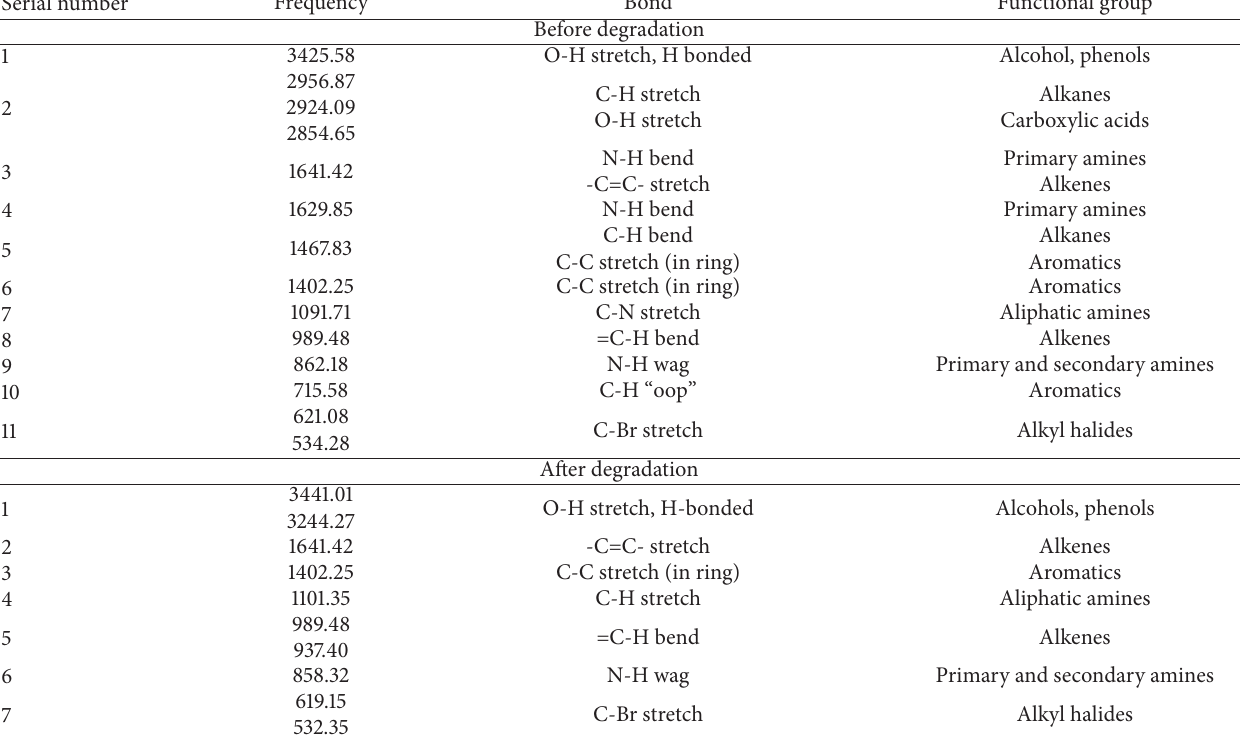
Table 2: Table showing frequencies obtained in FTIR and their corresponding functional groups before degradation and after degradation of